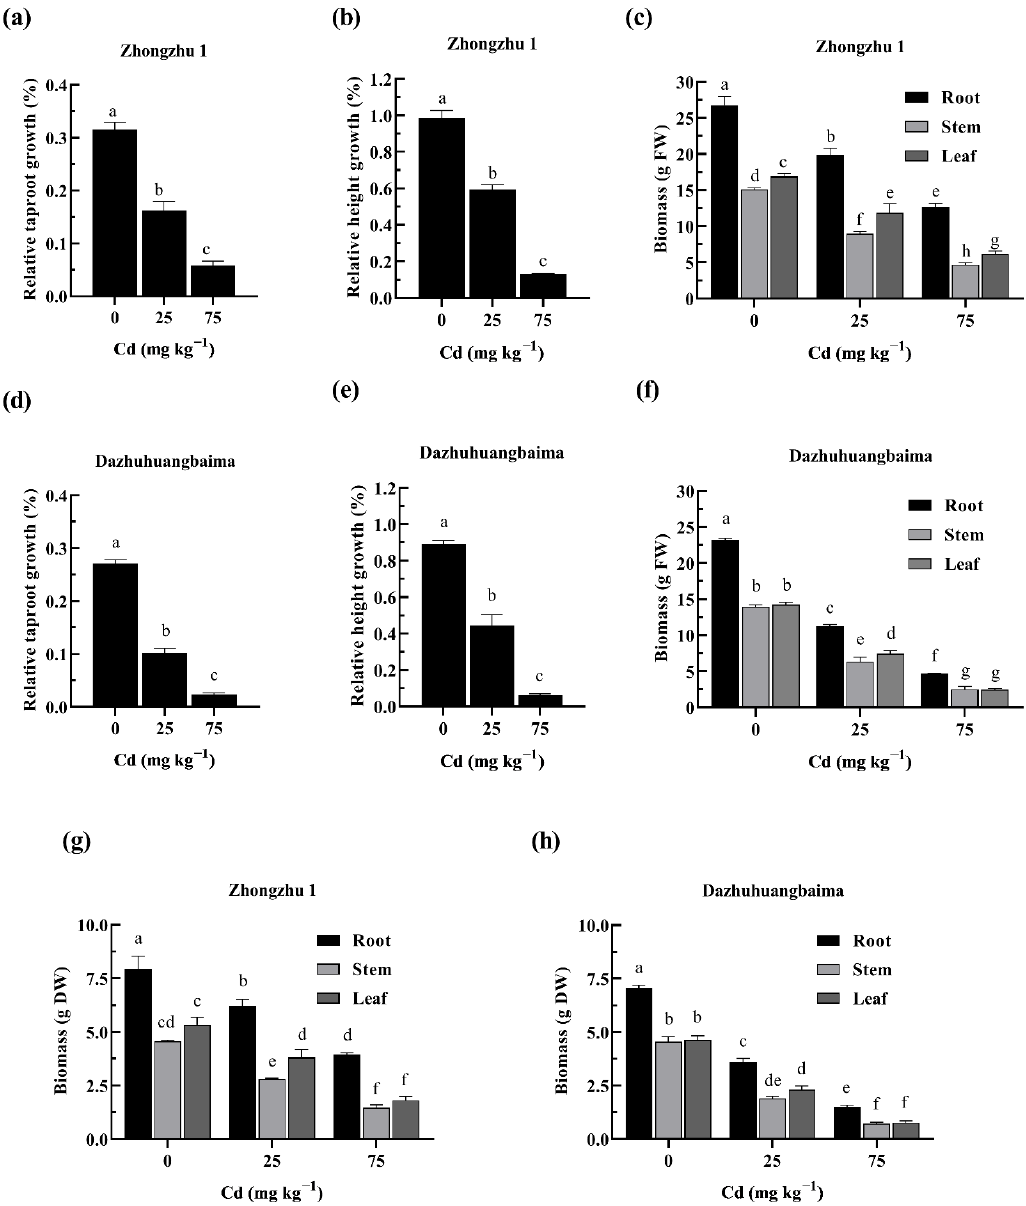
Figure 1. The effect of Cd on the taproot length, plant height, and biomass of ramie. ( a ) The relative taproot growth of ‘Zhongzhu 1’. ( b ) The relative height growth of ‘Zhongzhu 1’. ( c ) The fresh weight (FW) of ‘Zhongzhu 1’. ( d ) The relative taproot growth of ‘Dazhuhuangbaima’. ( e ) The relative height growth of ‘Dazhuhuangbaima’. ( f ) The FW of ‘Dazhuhuangbaima’. ( g ) The dry weight (DW) of ‘Zhongzhu 1’. ( h ) The DW of ‘Dazhuhuangbaima’. Data presented as means ± SD ( n = 18). Different letters indicate significant differences at p ≤ 0 .05.